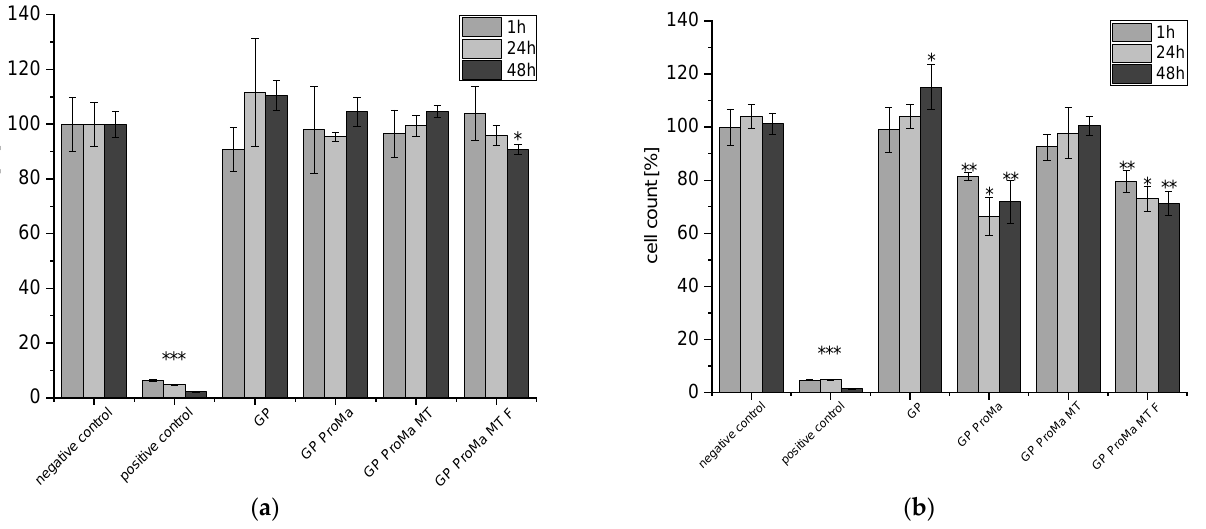
Figure 9. ( a ) Cell count [%] of the HaCaT cells (human keratinocyte cell line) exposed to the sample extracts in DMEM for 1 h, 24 h, 48 h; ( b ) cell count [%] of the HaCaT cells exposed to the sample extracts in defined sweat solution for 1 h, 24 h, 48 h. Asterisks indicate significant deviations from the negative control (* p < 0.05; ** p < 0.01; *** p < 0.001) (ProMa: prolamine–silica sol coating, MT: silica sol (trimethylethoxysilane); F: fumaric acid particles; GP: glassine paper 50 g/m 2 ).